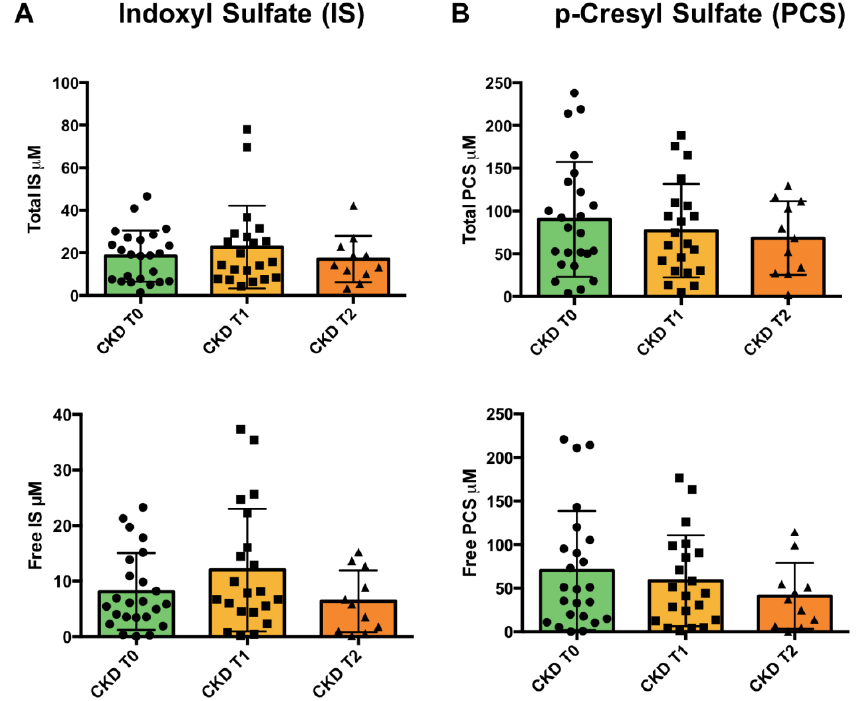
Figure 4. Uremic toxins levels in plasma of CKD patients. ( A ) Total (upper) and free (lower) levels of indoxyl sulfate (IS). ( B ) Total (upper) and free (lower) levels of p-cresyl sulfate